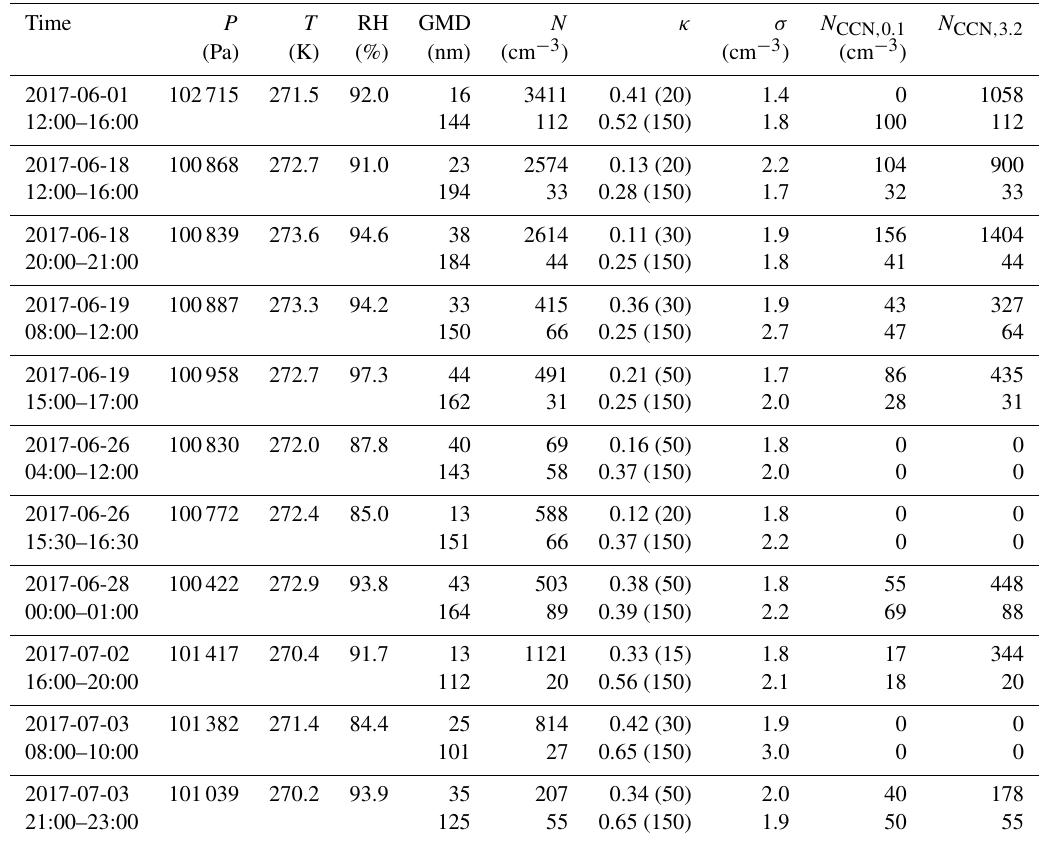
Table 3. Input parameters and the results from parcel model (Rothenberg and Wang, 2016). Here: P – pressure (Pascal), T – temperature (Kelvin), RH – relative humidity (%), GMD – geometric mean diameter of two modes fitted to PNSD (in nanometers); N – number concen- tration of particles in the mode (in particles per cubic centimeter), κ – hygroscopicity parameter kappa (derived for particle sizes indicated in bracket), σ – the shape parameter (standard deviation of the log of the distribution), N CCN , 0 . 1 , and N CCN , 3 . 2 – the number concentration of CCN at two different vertical wind velocities, 0.1 and 3.2ms − 1 . Note: κ for specific GMDs was adopted from the nearest value of measured 15, 20, 30, 50, and 150nm particle hygroscopicity. For example, hygroscopicity of 20nm particles was used as an input value for the GMD of 16nm mode particles. Date format: